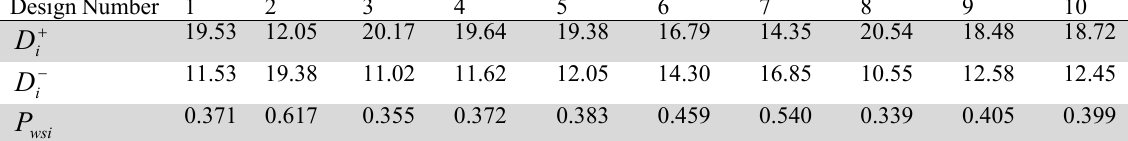
Relative closeness values of each alternative with ws-TOPSIS Design Number